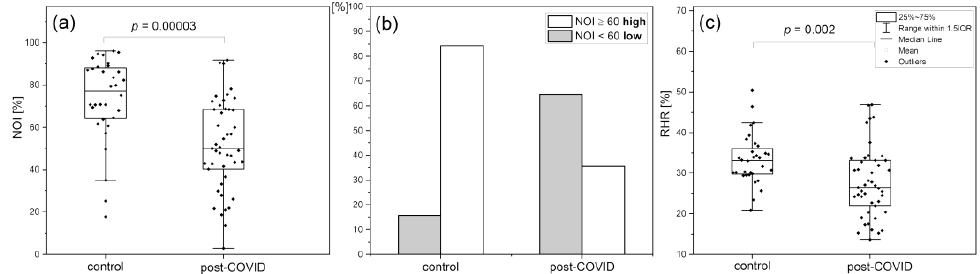
Figure 10. Comparison of NOI ( a , b ) and RHR ( c ) parameters in the post-COVID and control group; the p -values were calculated by the Mann – Whitney test ( a ) and the two sample t -test ( c ) [45]. Repro-duced from: Chudzik, M.; Cender, A.; Mordaka, R.; Zielinski, J.; Katarzynska, J.; Marcinek, A.; Gebicki, J. Chronic fatigue as-sociated with post-COVID syndrome versus transient fatigue caused by high-intensity exer-cise: are they com-parable in terms of vascular effects? Vasc Health Risk Manag. 2022 , 18 , 711–719; DOI:10.2147/VHRM.S371468, with the permission of Dove Medical Press